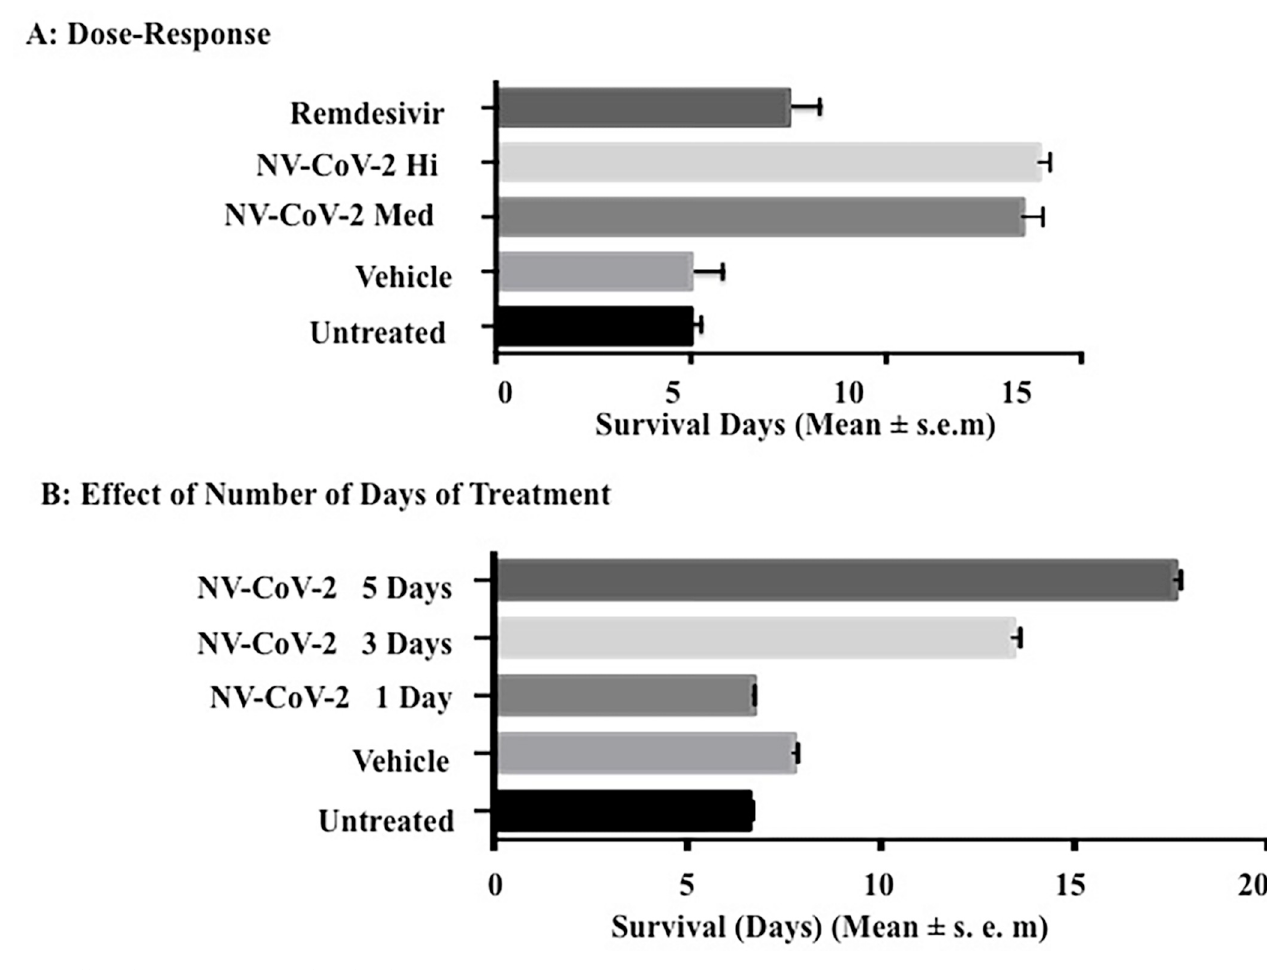
Fig 2. Effect of NV-CoV-2 in rats infected with CoV-NL63, in vivo .